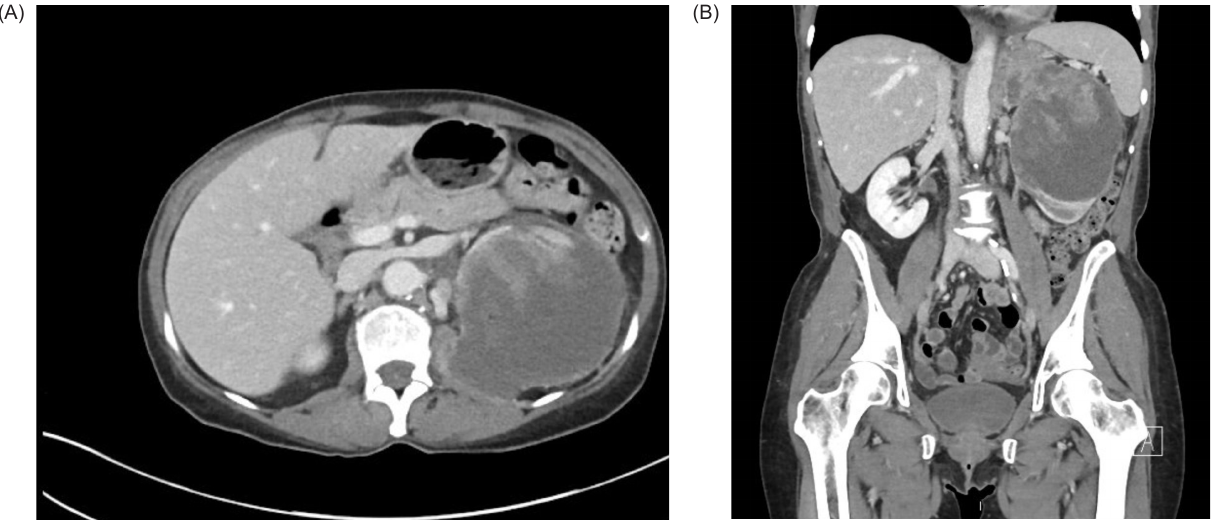
Figure 1: CT of the abdomen and pelvis with IV contrast. (A) Transverse and (B) coronal views demonstrating a 9.2 × 9.3 × 12.4 cm left renal mass with extension into the left